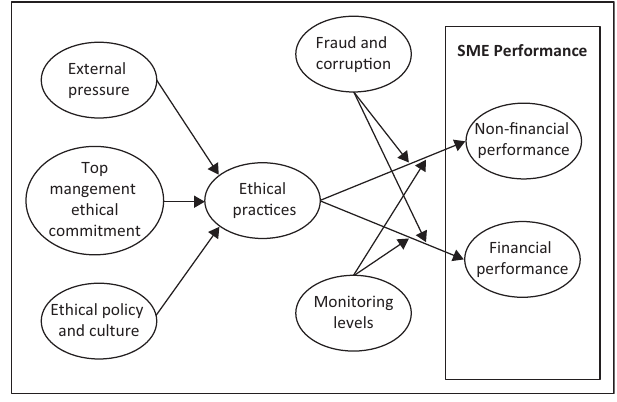
FIGURE 1: Research